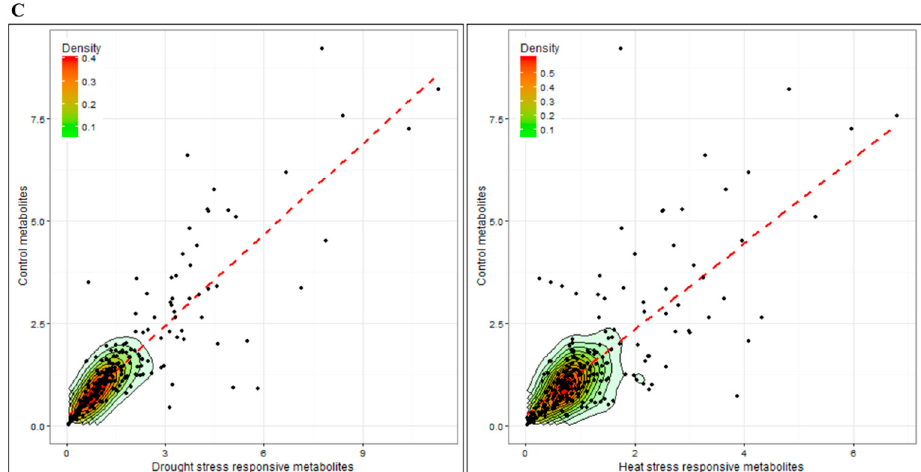
Figure 1. Metabolomics data of soybean leaves under drought and heat stress. ( A ) Classification of differentially expressed metabolites into chemical groups, in response to both drought and heat stress, based on their metabolic designations. Percentage values symbolize abundance of metabolites in each functional class. ( B ) Principal component analysis (PCA) biplot of all the variable metabolites originating from three different treatments i.e., control, drought and heat is shown here, (cos2 = the quality of the individuals on the factor map displayed as color intensity). ( C ) Scatter plot distribution of all groups of metabolites revealed that there is a linear positive correlation between the expression levels of control metabolites, and drought stress and heat stress-responsive metabolites. The best scatter of the metabolites was observed at the base of both the plot, which is visualized with an intensity level gradient ranging from 0.1 to 0.5. (Plot created by using R 3.3.1 software with the ggplot package).